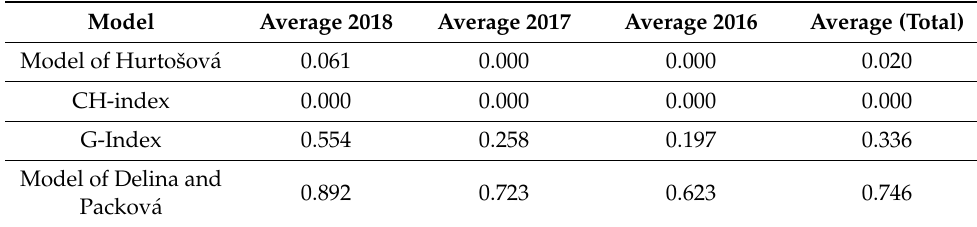
Table A6. Average results of testing models using the F1 Score